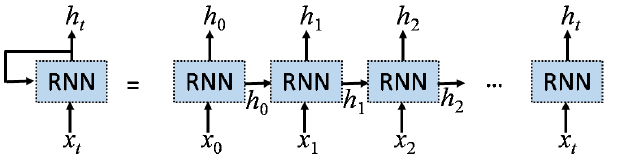
Figure 4. The structure of the RNN (the left part to the equation sign) and its logical structure for processing time series (the right part to the equation